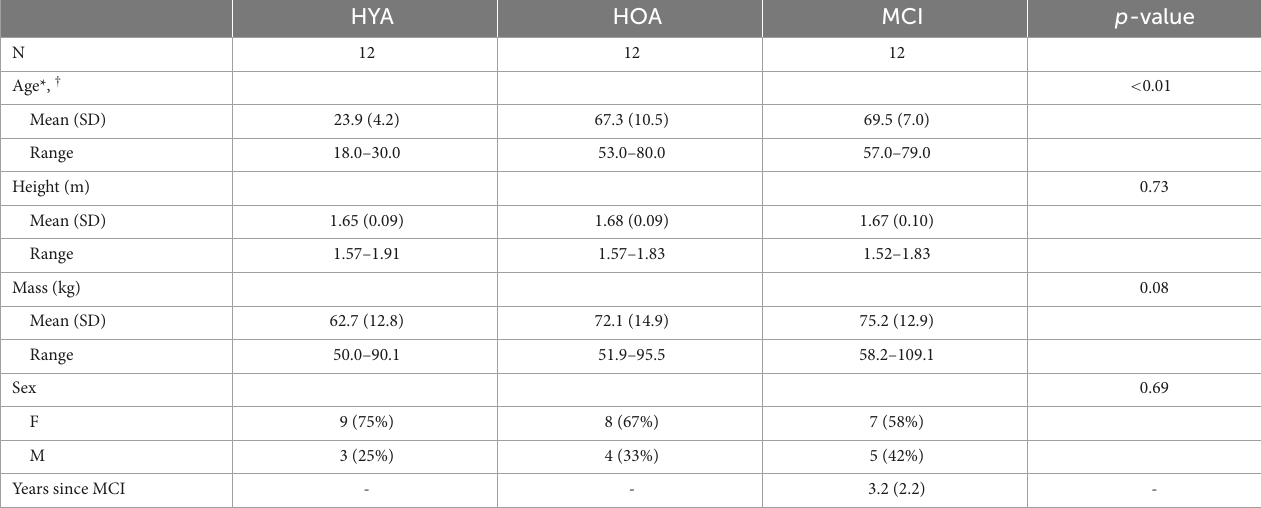
TABLE 1 Demographic characteristics of each participant